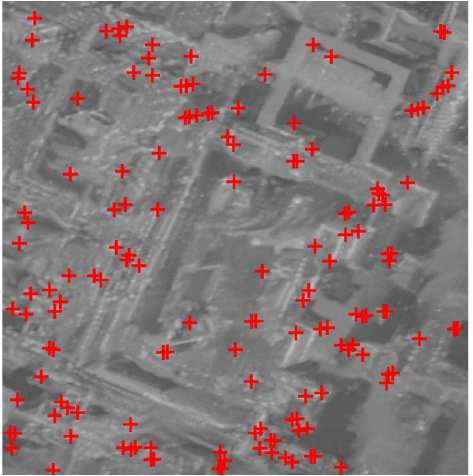
Figure 10. The feature points detected in the SAR image patch in the TUM main campus